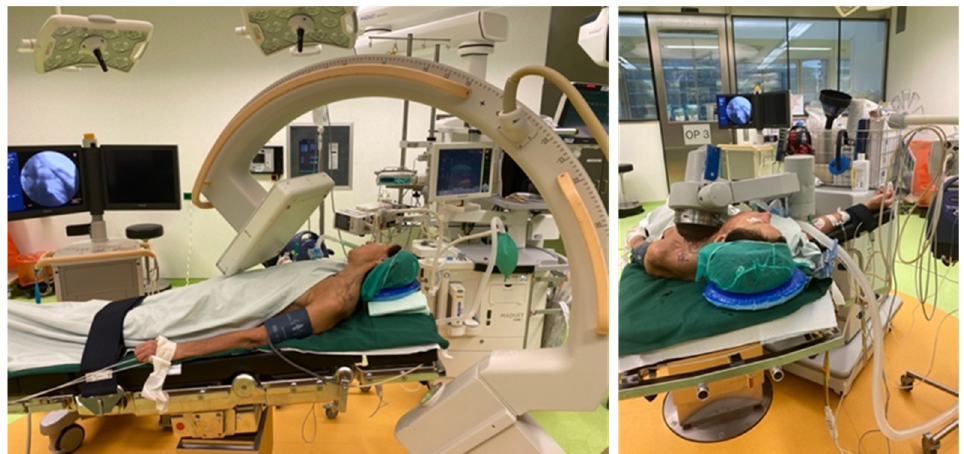
Figure 1. Pre-operative evaluation of the fracture site and determination of the direction of application ( left ). The shockwave therapy head is positioned on the clavicle region ( right ).